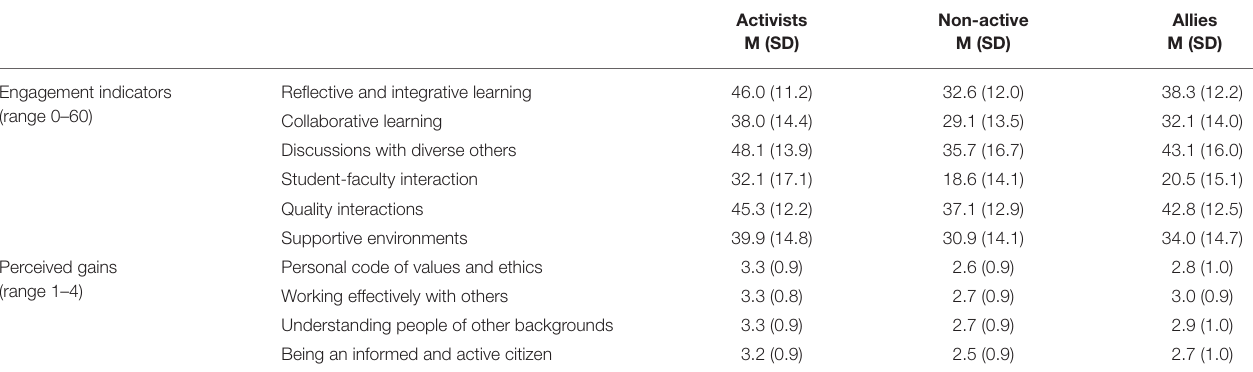
TABLE 6 | Select engagement indicators and perceived gains by civic engagement student